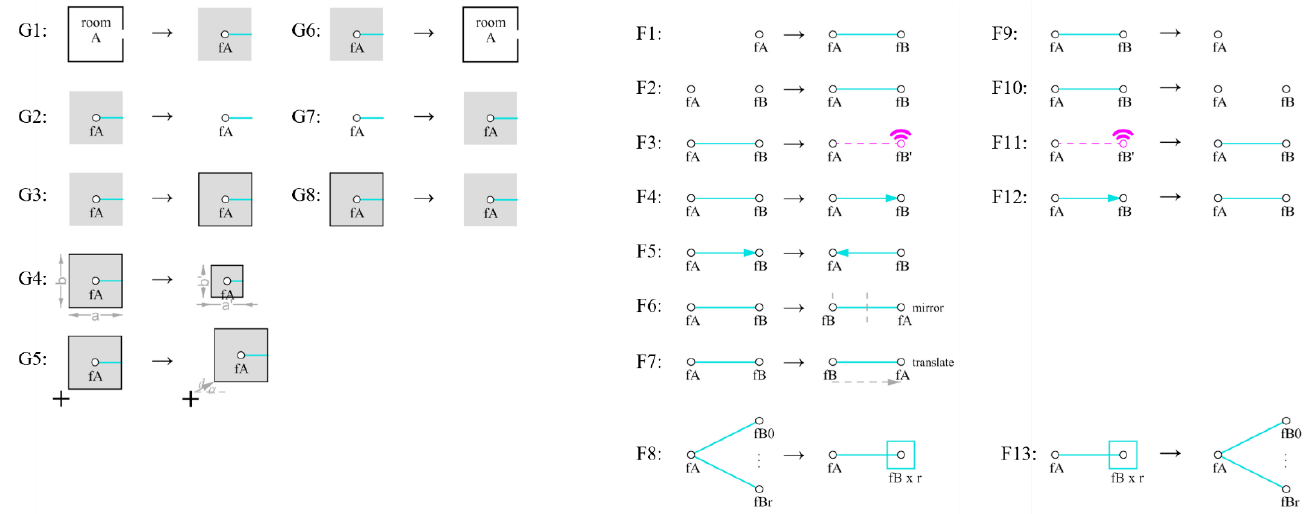
Figure 6. A set of shape and graph rules from revisiting